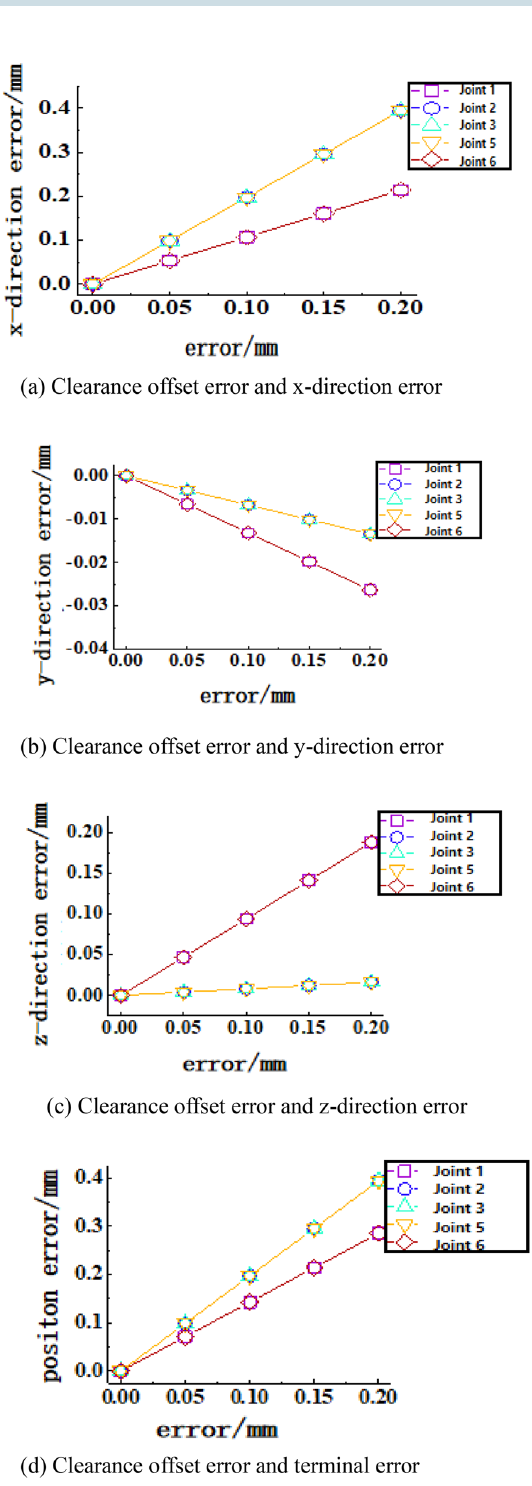
Figure 13. Joint clearance offset error-terminal position sensitivity curve. ( a ) Clearance offset error and x-direction error, ( b ) Clearance offset error and y-direction error, ( c ) Clearance offset error and z-direction error, ( d ) Clearance offset error and terminal